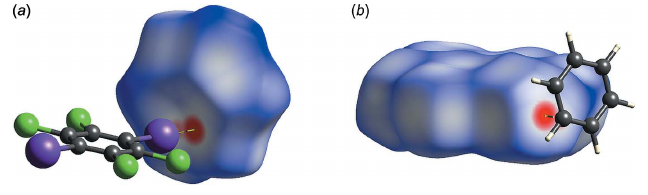
Figure 2 Two views of the Hirshfeld surface of the title solvate highlighting the short contact between I1 and C4 with the halobenzene shown as a ball and stick model in ( a ) and the benzene ring shown as a ball and stick model in ( b ).